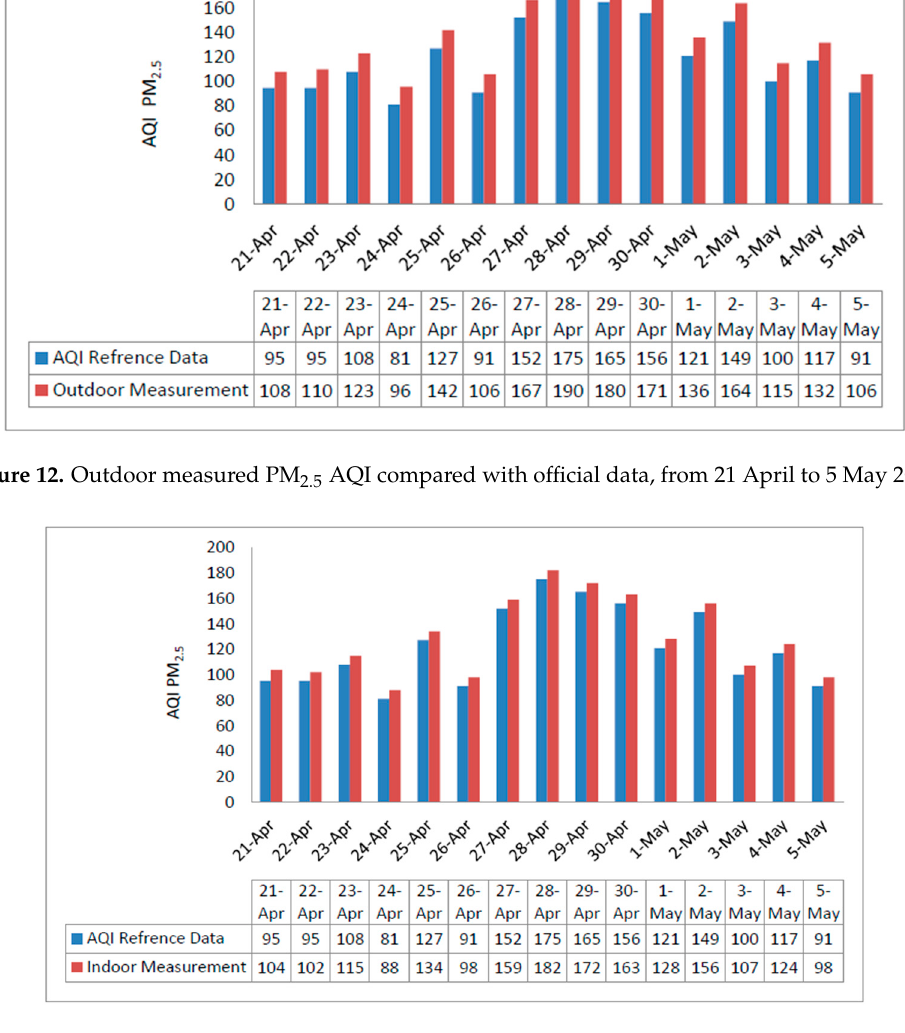
Figure14. Indoor measured PM 2.5 AQI value comparison with official data, for 15 days from 21 April to 5 May, 2018.